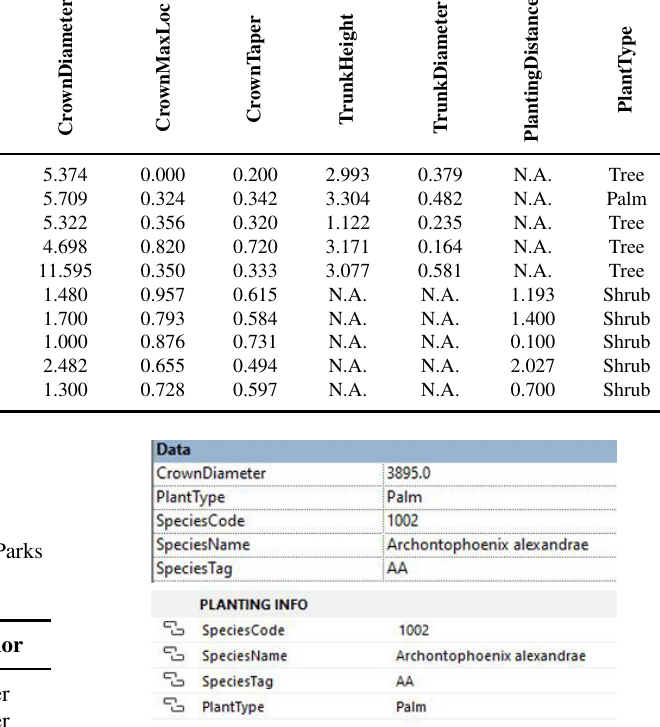
Figure 6. Placeholders in both Revit (top) and ArchiCAD (bottom) require parameters SpeciesCode and PlantType